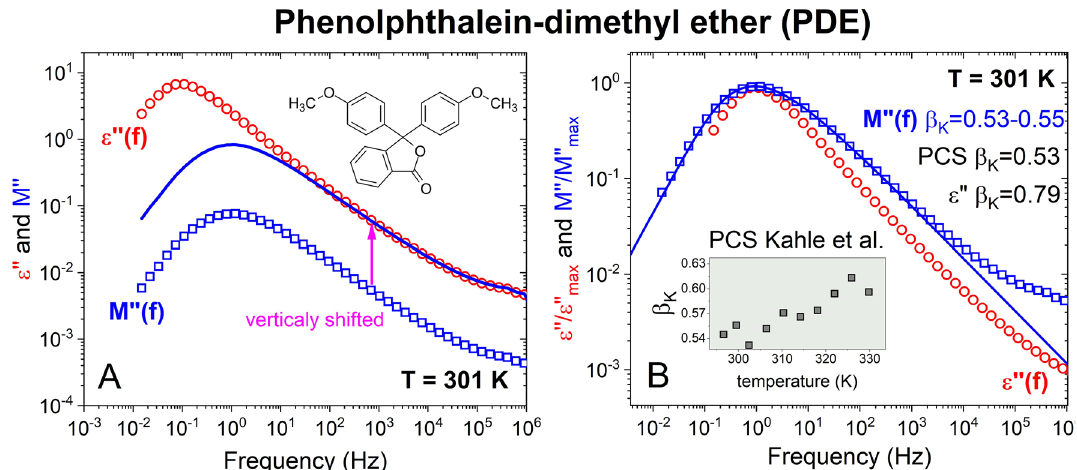
Figure 2. ( A ) Shows data of ε ″ ( f ) and M ″ ( f ) (red and blue scatters, respectively), and the vertically shifted M ″ ( f ) data (solid line) of phenylphthalein-dimethylether (PDE) at T = 301 K. In ( B ) data are normalized by the loss maxima and the frequencies to show the broader dispersion in M ″ ( f ) than in ε ″ ( f ) and the β M K = 0.53–0.55, β PCS K = 0.53 (see inset from Ref. 39 ), and β DS K = 0.79 at 301